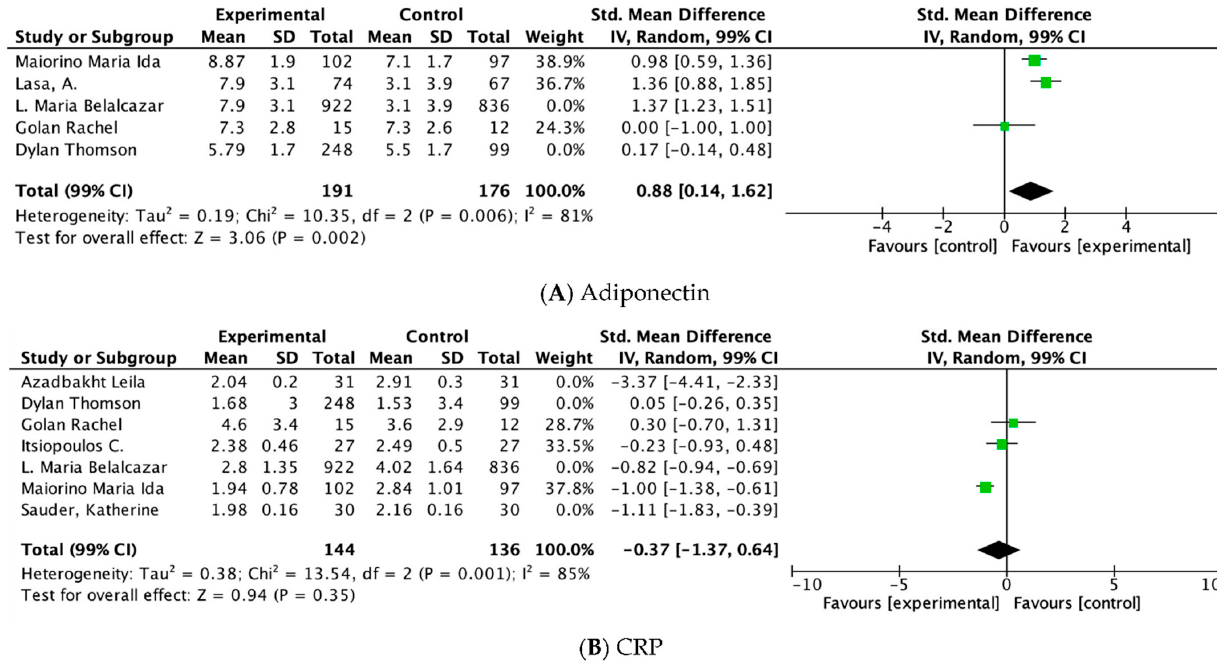
Figure 5. Subgroup by type of dietary pattern of intervention studies. Forest plot of comparison between clinical trials. Subgroup represents type of Dietary Pattern: MD is represented. Other studies with different DP are weighted 0%. Results present SMDS, and 99% CI for DPs evaluated. Final values, outcome: ( A ) Adiponectin (ug/mL0 and ( B ) CRP (mg/L) with the intake of Mediterranean Diet Abbreviations: CRP; C-Reactive Protein; WMD, weighted mean